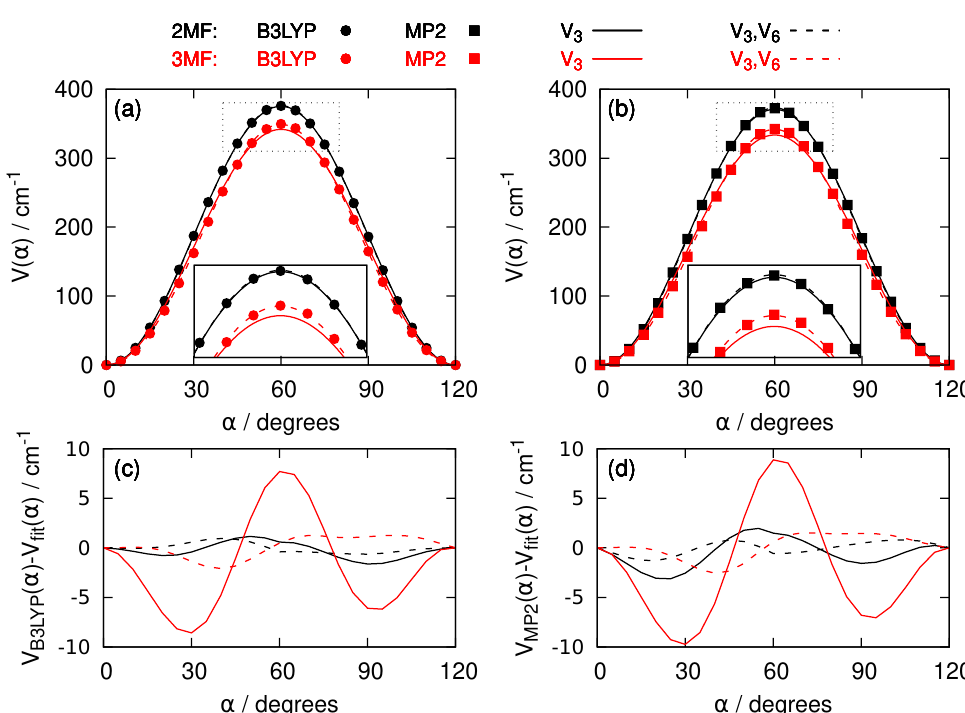
Figure 4. ( a ) Torsional potential V as a function of the torsional angle α for 2-MF (black dots and curves) and 3-MF (red dots and curves). The electronic energies from B3LYP calculations with the aug-cc-pVTZ basis set are represented by dots. The solid curves come from the B3LYP data after a fit on V 3 and fixing V 6 to zero in Equation (5). The dashed curves are obtained after a fit on both V 3 and V 6 in Equation (5). A blow-up around the maximum of the curves is pictured in the inset. ( b ) Same as ( a ) for MP2 data. The MP2 electronic energies are shown as squares. ( c ) Energy differences between the B3LYP results and the adjusted curves with the same color and style code as ( a ). ( d ) Same as ( c ) for MP2